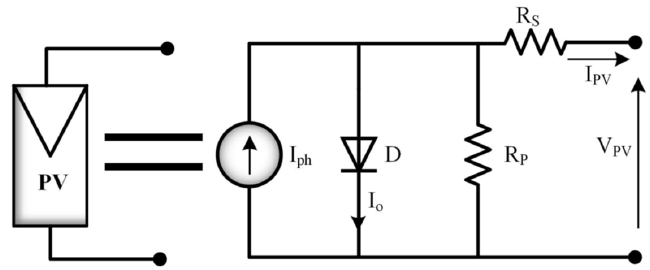
Figure 1. PV array equivalent model.